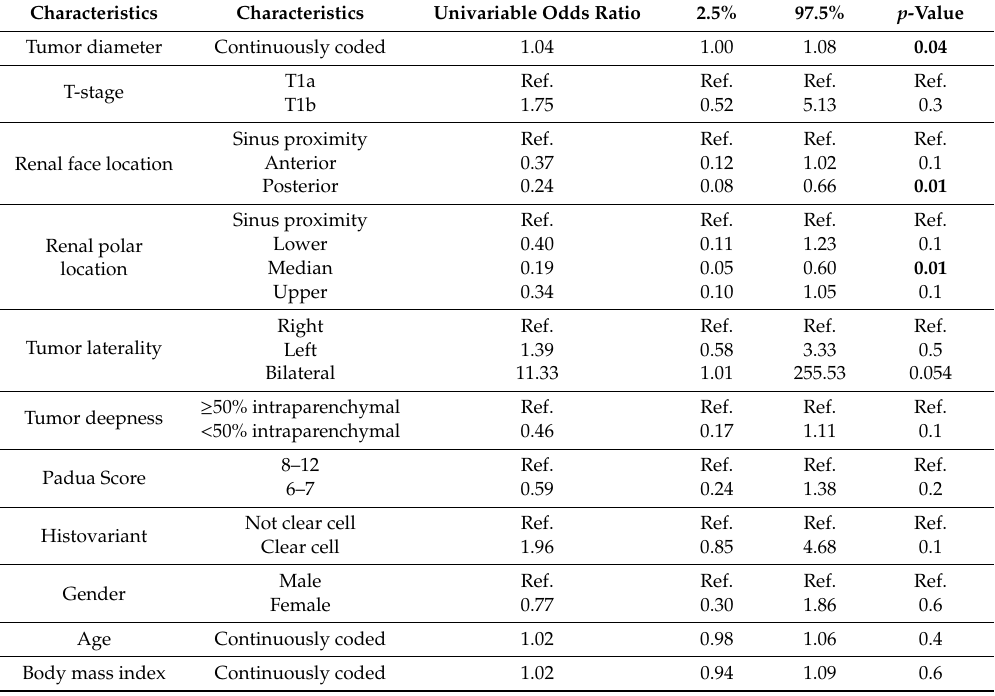
Table 3. Univariable logistic regression models prediction of multiple ablations rate according to clinical and pathological